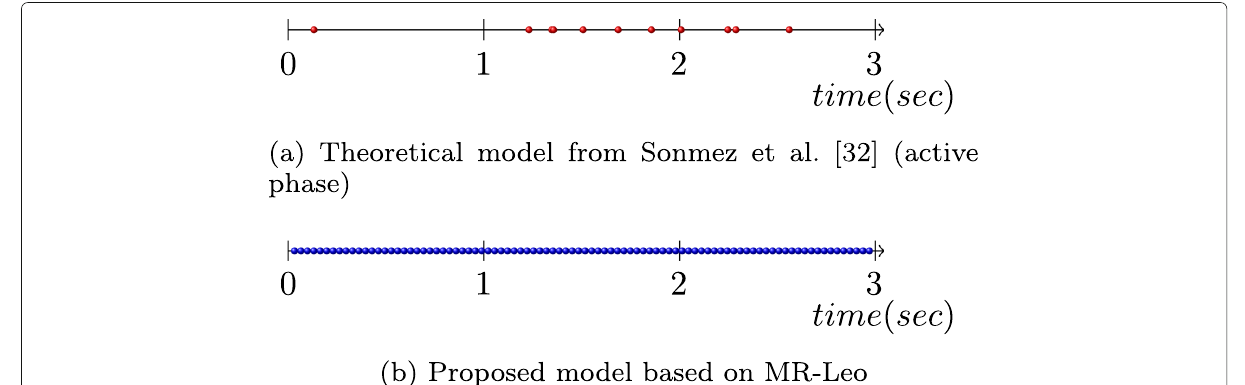
Fig. 16 Task arrival times for one sample of generated tasks using different models